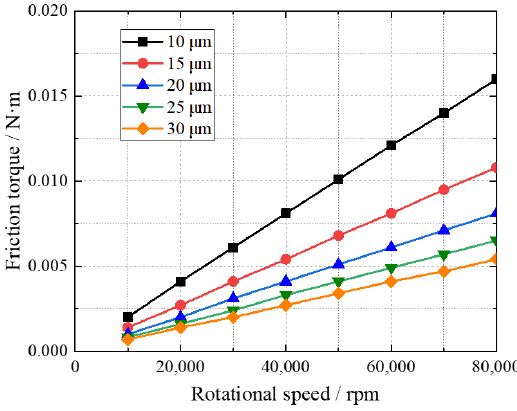
Figure 13. Friction torque of hydrogen gas bearings with gas film clearance.